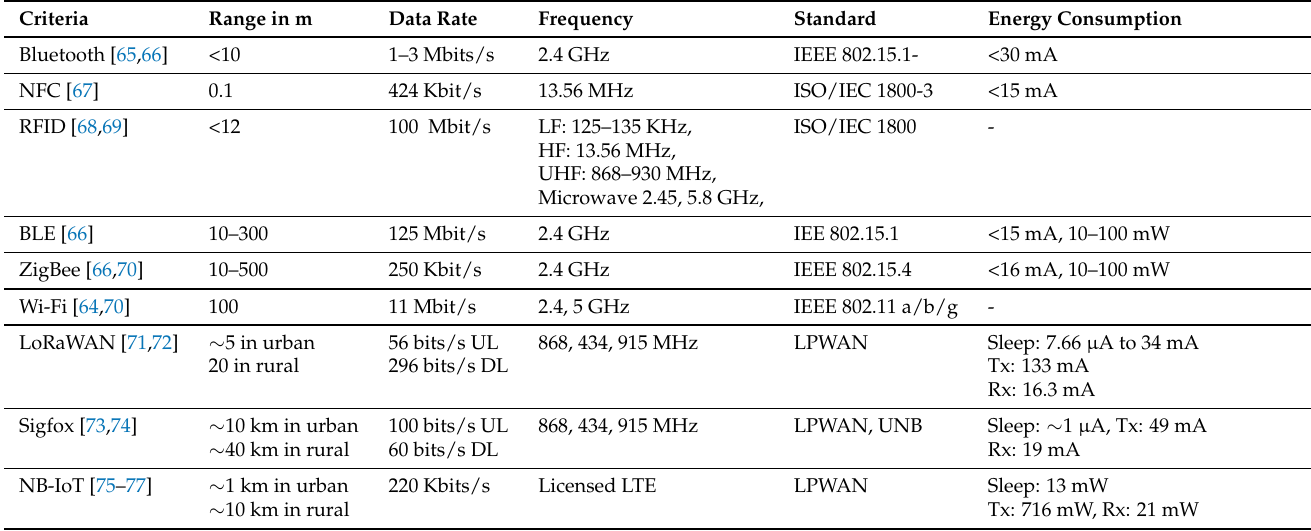
Table 3. Comparison between communication technologies used in the